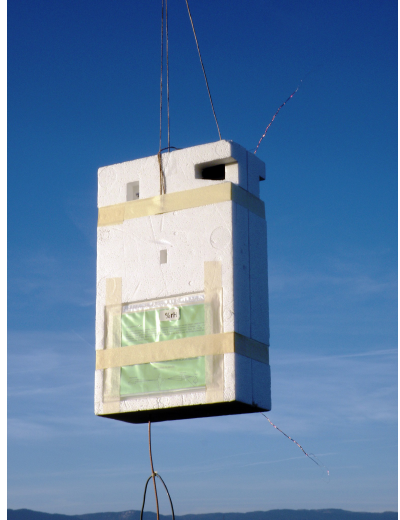
Figure 11. Intermet iMet-1-RS radiosonde used for FPH flights at Boulder.